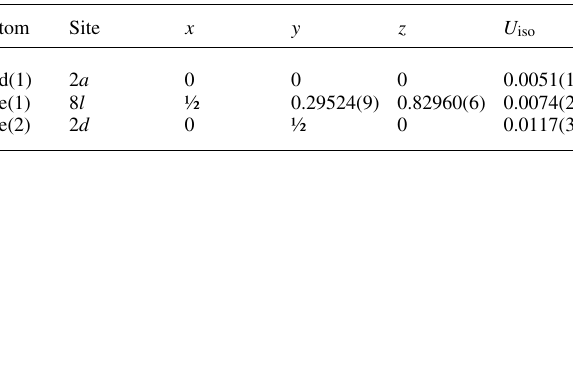
Table 4. Atomic coordinates and displacement parameters (in Å 2 ) . Table 3. Data collection and handling.